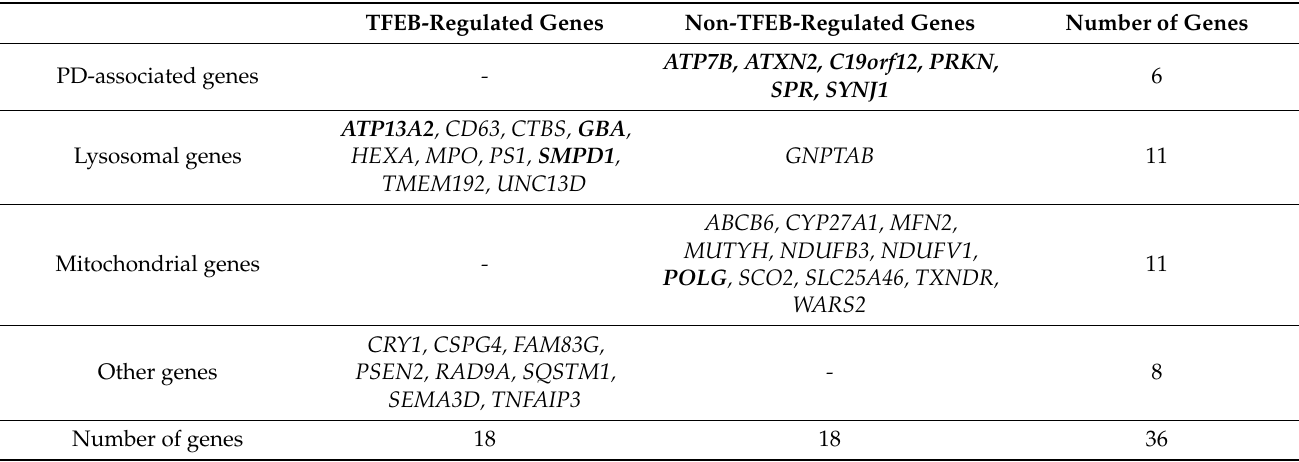
Table 2. Genes with overrepresented variants in PD